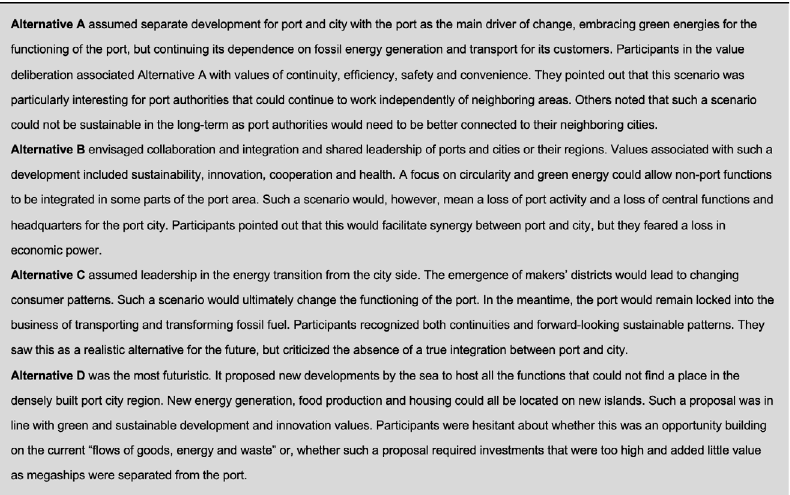
Alternatives A-D: Four scenarios developed for the pilot value deliberation. The alternatives proposed to participants focused on the future relationship between ports, cities and their